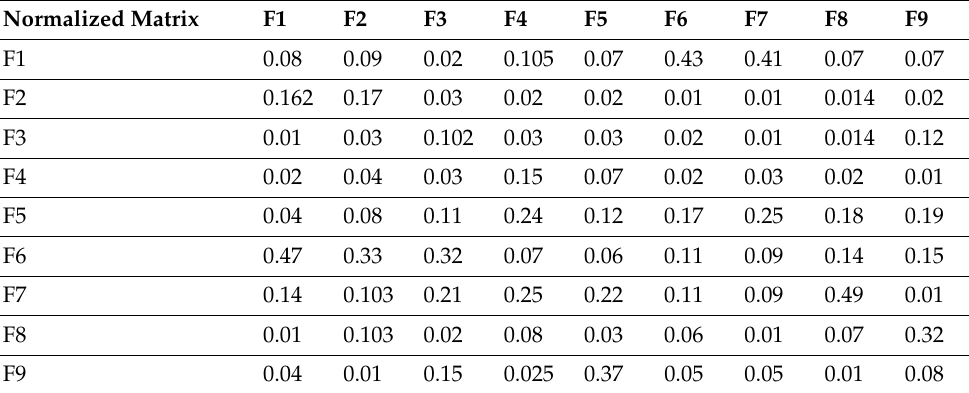
Table 7. AHP Normalized Pairwise Comparison Matrix.